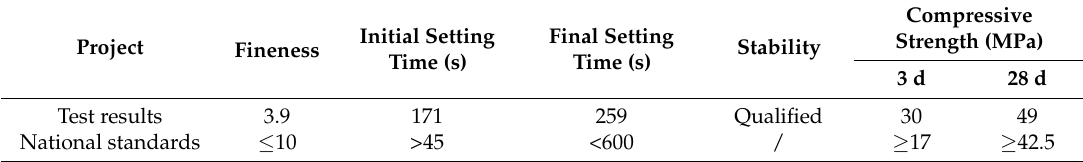
Table 2. Material parameters of cement.